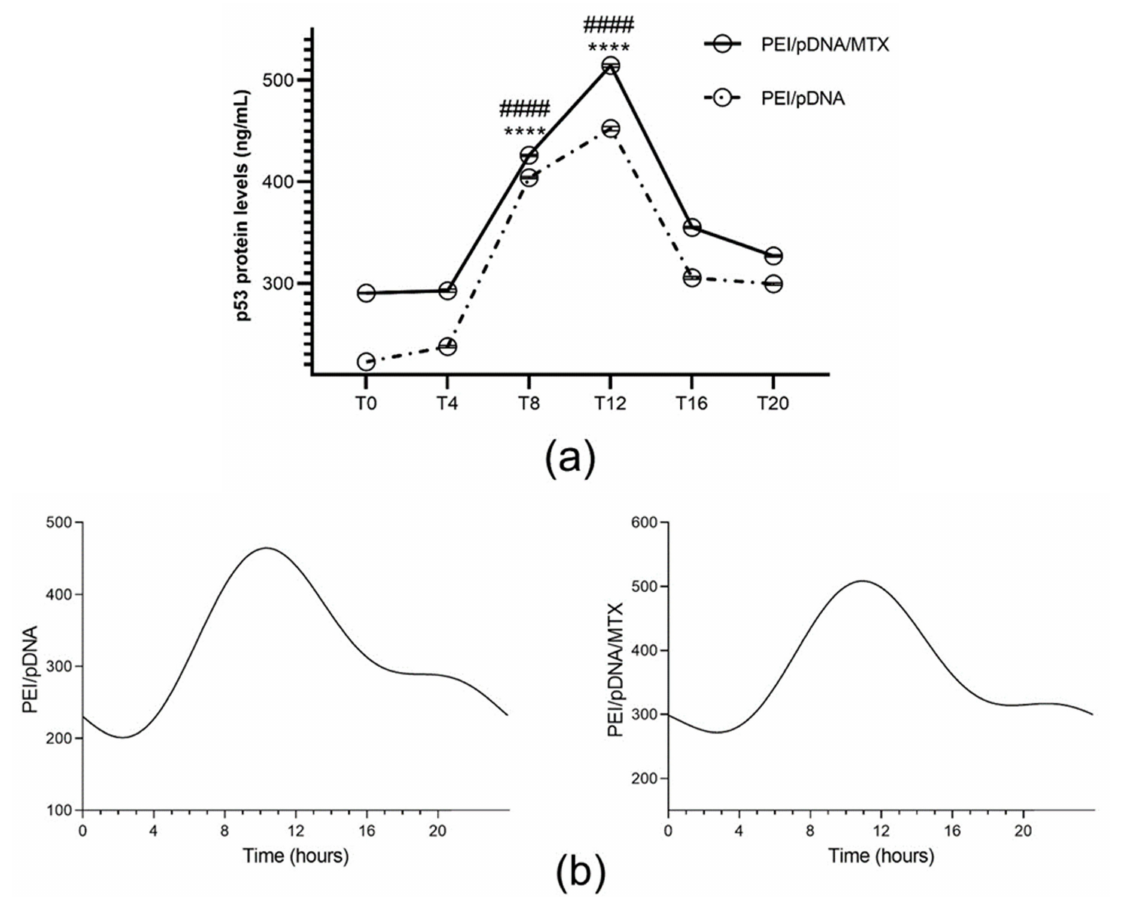
Figure 6. Quantification of p53 protein levels (ng/mL) for each time point. ( a ) p53 protein levels have been determined 48 h after transfection mediated by PEI/pDNA and PEI/pDNA/MTX nanoparticles by using p53 pan ELISA kit. Each data point represents the mean ± SD (n = 3) and were analyzed by two-way ANOVA with the Bonferroni test. At time T8 and T12, substantial levels of protein were found in Hela cells, in comparison to other time points (**** p < 0.0001). Additionally, the difference between PEI/pDNA and PEI/pDNA/MTX is statistically significant for T8 and T12 (#### p < 0.0001). ( b ) Circadian oscillations are statistically significant as analyzed with CircWave ( p = 0 for both PEI/pDNA and